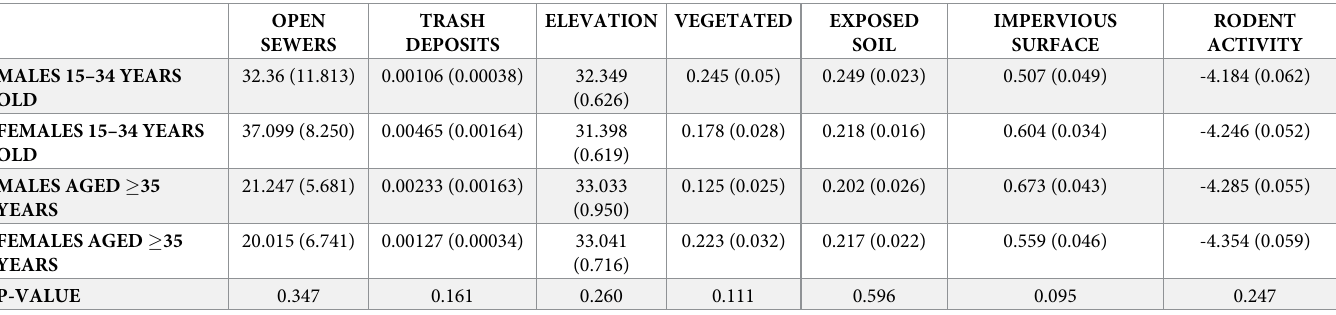
Table 2. Movement-induced exposure to leptospirosis transmission sources.